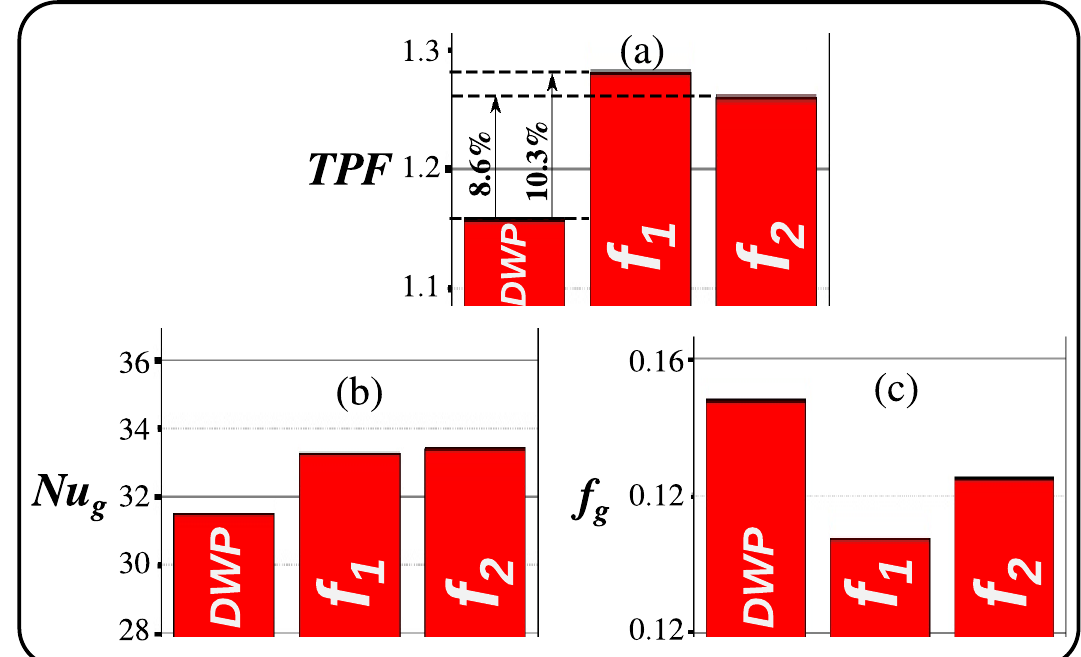
( c ) Global friction factor f g . The DWP base design and the two adjoint-based optimum designs were compared with a TPF morph-based objective f 1 and a WSM-based objective f 2 . The TPF Morph optimal design is obtained at a computational cost reduced by a factor of 10, compared to the WSM optimal design.